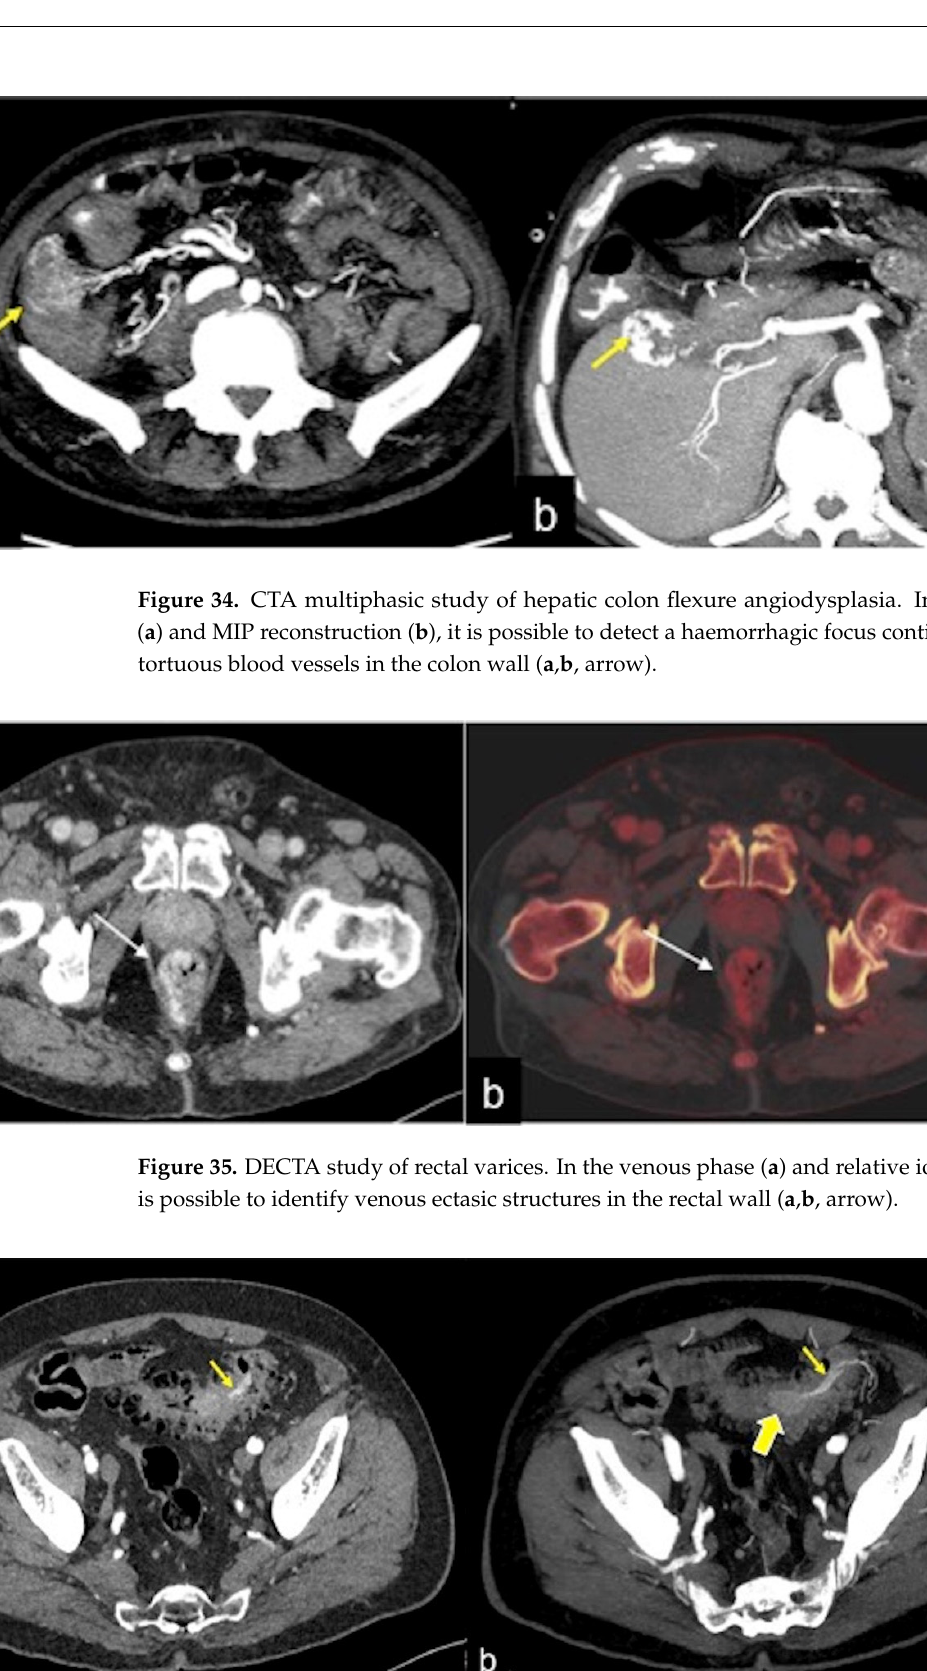
Figure 36. CTA multiphasic study of pedunculated polyp of the sigma. In the arterial phase ( a ) and relative MIP ( b ), it is possible to define an arterial vascular axis (arrow ( a , b )) supporting a large polyploid formation (large arrow ( b )).